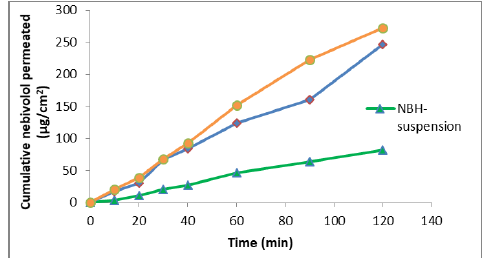
Figure 4.The cumulative amount of NBH permeated through rat intestinal sac from NBH- loaded conventional, supersaturable SNE and plain suspension.